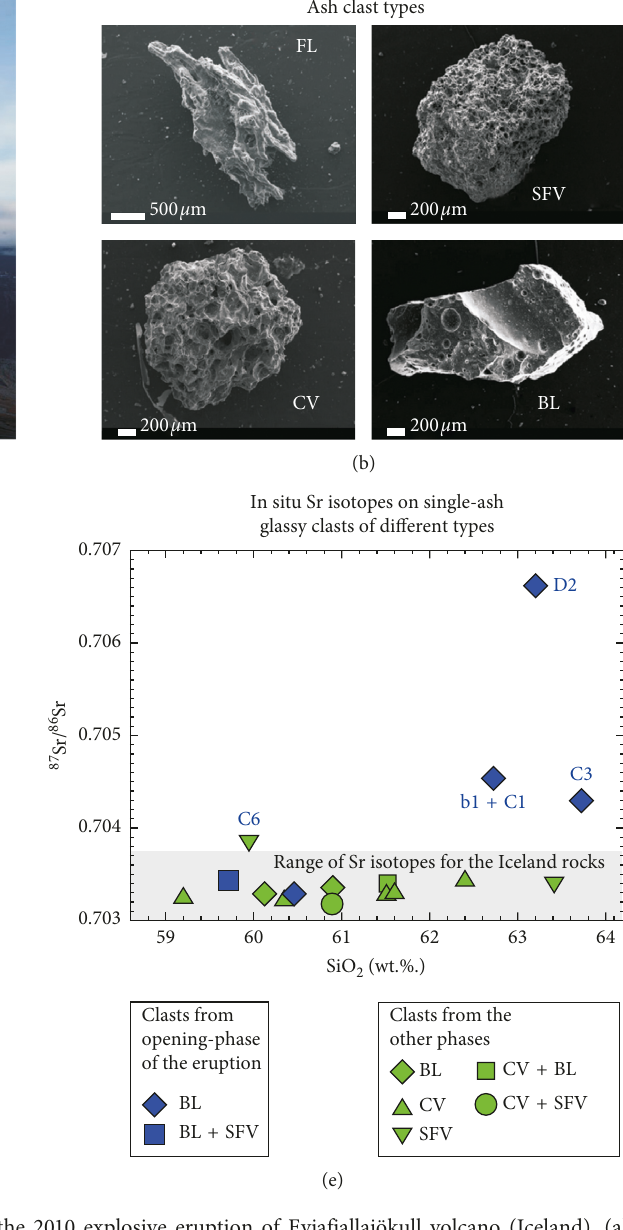
fluidal; SFV spongy finely vesicular; CV coarse (cid:31) (cid:31) (cid:31)